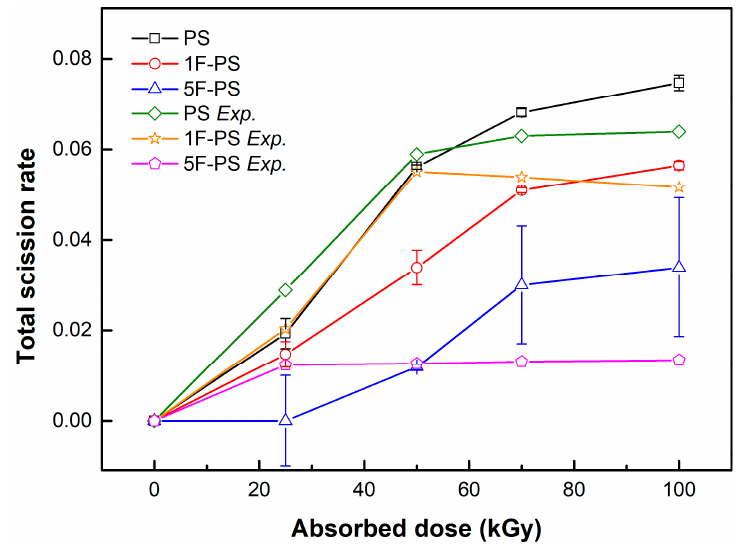
Figure 14. Total Scission Rate.